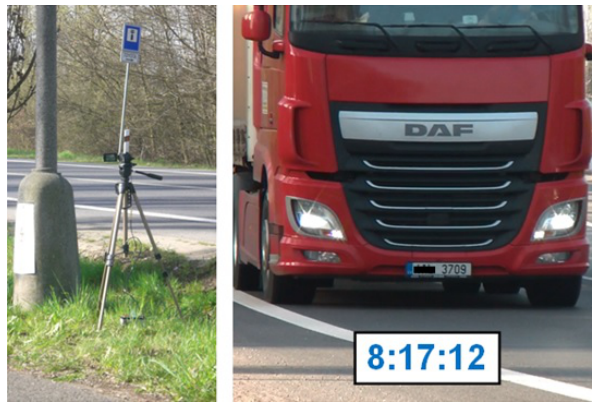
Figure 2: Písek – entry to the section of the 1 st class road no. I/29 in km 0,373